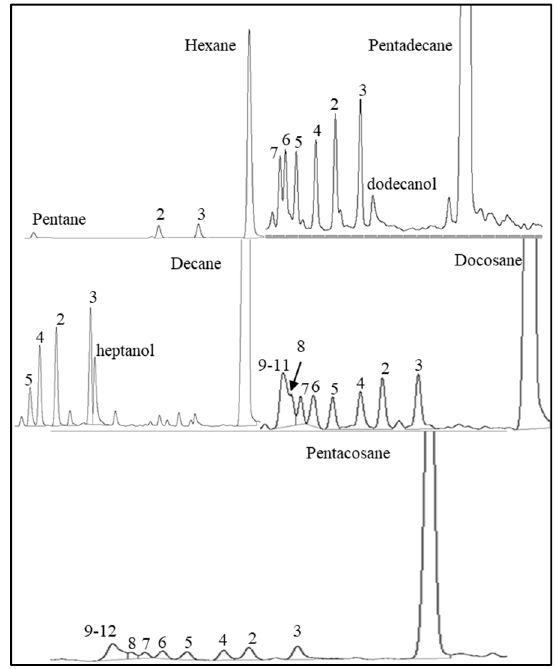
Figure 9. A chromatographic picture comparing different branching materials of specific carbon materials for a 0 K (i.e., no potassium promoter) active iron catalyst. This represents mixed oils from several iron runs where the oils were exposed to H 2 at 0.68 bar for 5 min using Pt/C catalyst converting all olefinic materials to alkanes. All runs at 230 °C, 12.1 bar, 0.7 H 2 /CO with a WHSV = 2.